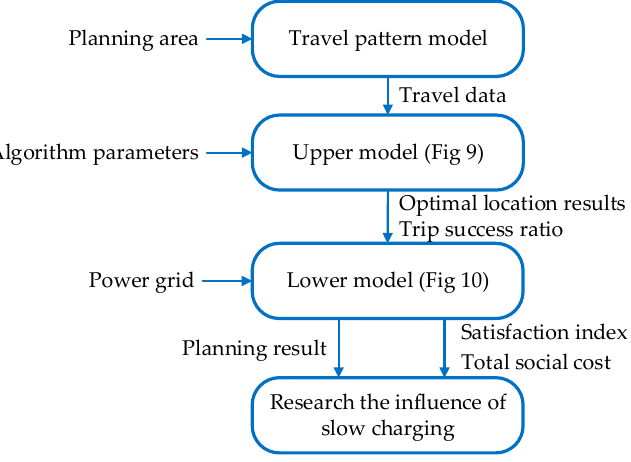
Figure 1. A block diagram of the proposed method.